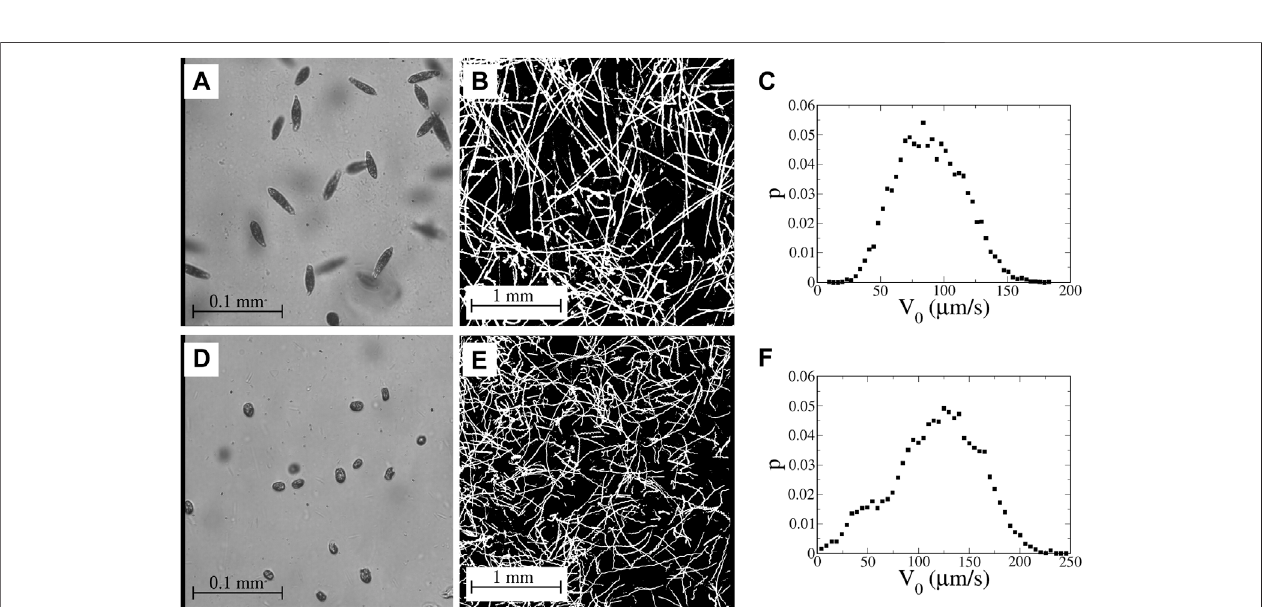
FIGURE4|(A) Imageofeuglena,viewedat40Xmagni fi cationwitha fi eldofviewof320 μ m. (B) Streakimageshowingmotionoftheeuglenainthechannelwithno imposed fl ow; 4X magni fi cation (3 mm fi eld of view). (C) Measured probability distribution function (PDF) of speeds of swimming euglena in the absence of an imposed fl ow. (D) Image of tetraselmis, viewed at 40X magni fi cation. (E) Motion of tetraselmis with no imposed fl ow; 4X magni fi cation. (F) PDF of speeds of tetraselmis in the absence of an imposed fl ow. (Movies corresponding to the images in (B) and (E) are available online in Supplementary Material ).